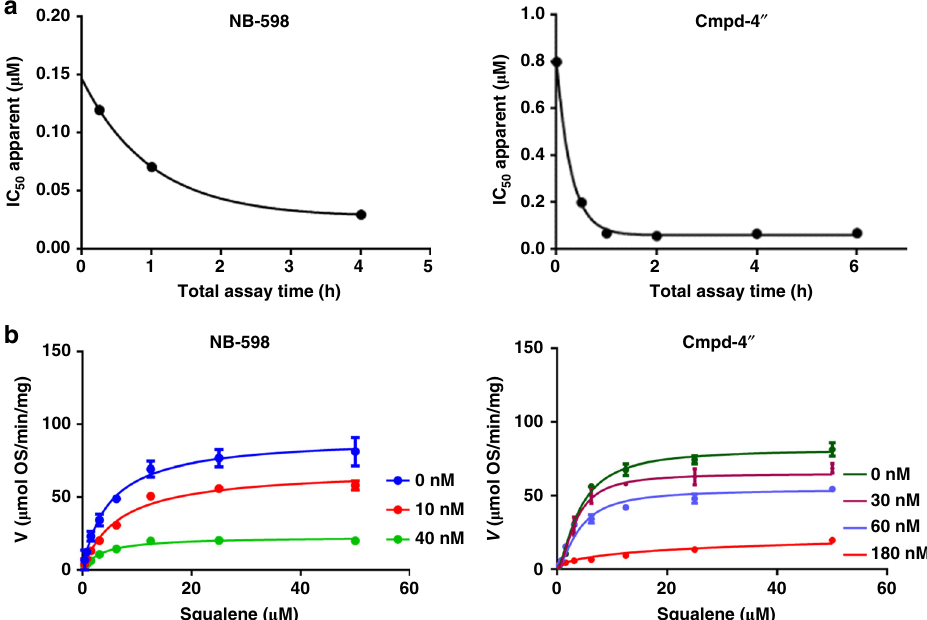
Fig. 6 Mechanism of action of SQLE inhibitors. a Time-dependent inhibition potency of NB-598 and Cmpd-4 ′′ . The IC 50 of NB-598 decreases from 120 nM to 30 nM and that of Cmpd-4 ′′ decreases from 800 to 69 nM upon increasing incubation time. b Mechanism-of-action study of NB-598 and Cmpd-4 ′′ . NB-598 study was performed with fi xed concentrations of inhibitor at 0, 10, and 40 nM indicating non-competitive inhibition with respect to squalene substrate. Cmpd-4 ′′ study was performed with fi xed concentrations of inhibitor at 0, 30, 60, and 180 nM indicating non-competitive inhibition with respect to squalene substrate. Points and error bars are the mean and standard deviation of triplicate experiments